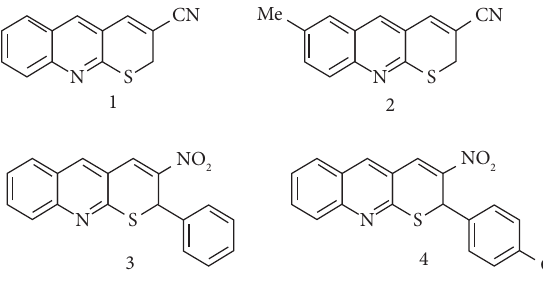
Figure 2: Structure of some compounds having 2 H -thiopyrano[2,3- b ]quinoline cores.